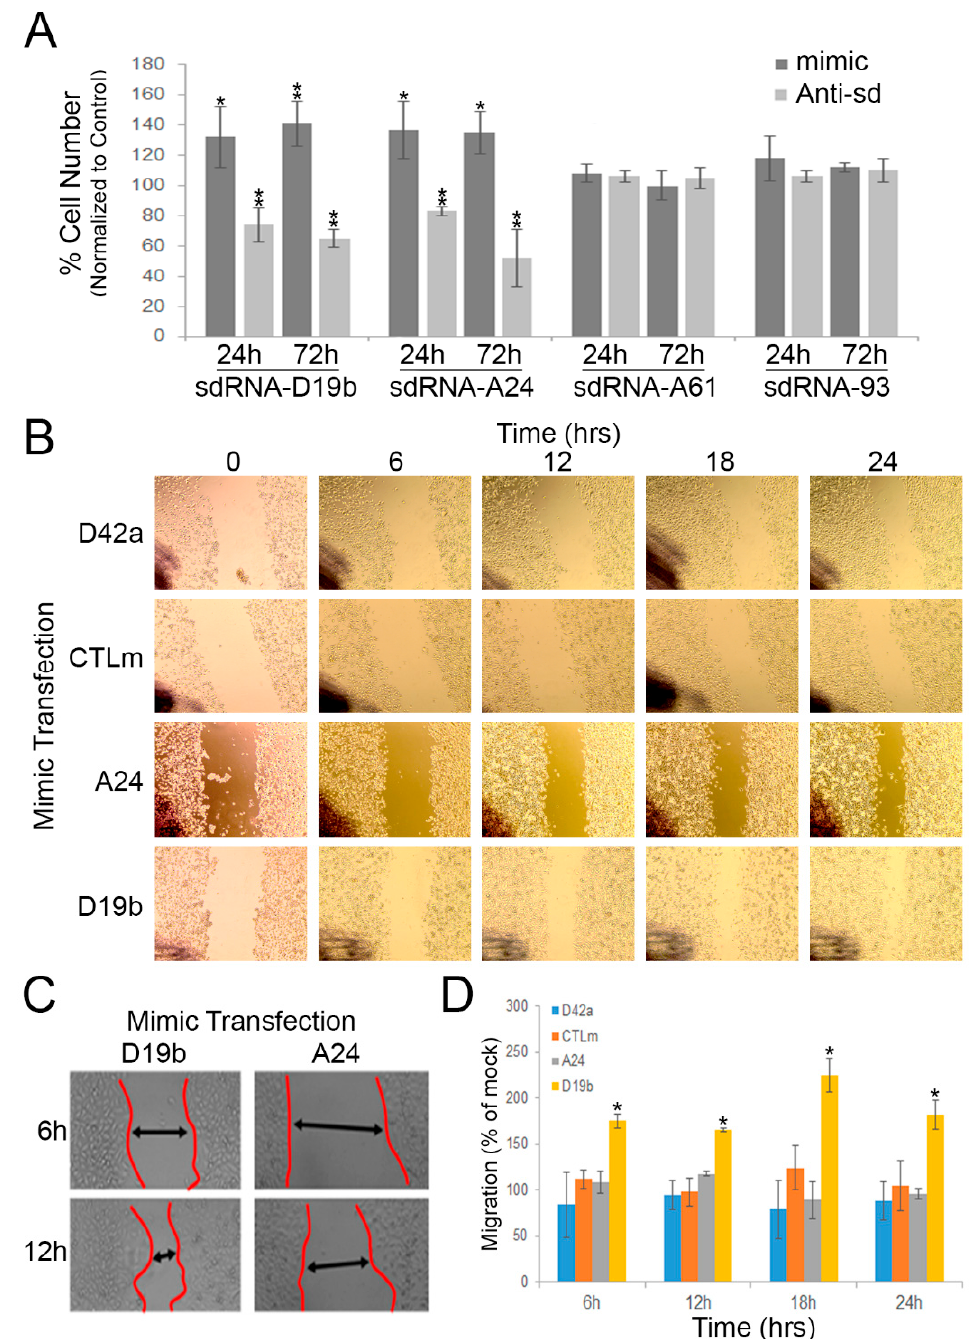
Figure 3. SdRNA-D19b and -A24 levels significantly impact PC3 cell proliferation and migration. ( A ) PC3 cells were transfected with indicated sdRNA mimic or antagomiR (Anti-sd). Cell counts were performed at 24 and 72 h then normalized to scrambled control transfections ( n = 8). * indicates p ≤ 0.05; ** indicates p ≤ 0.01; p -values by unpaired two-tailed t-test. ( B , C ) Representative migration (wound-healing) assays for PC3 cells transfected with the indicated sdRNA mimic. Wound border closure is indicated by black arrows. ( D ) PC3 migration assays quantified. Images were captured at the indicated times ( X -axis) and wound healing quantified using ImageJ as % migration normalized to scrambled control ( n ≥ 3). * indicates p ≤ 0.05; p -values by unpaired two-tailed t-test. D42a, sdRNA-D42a mimic; CTLm, scrambled mimic; A24, sdRNA-A24 mimic; D19b, sdRNA-D19b mimic.